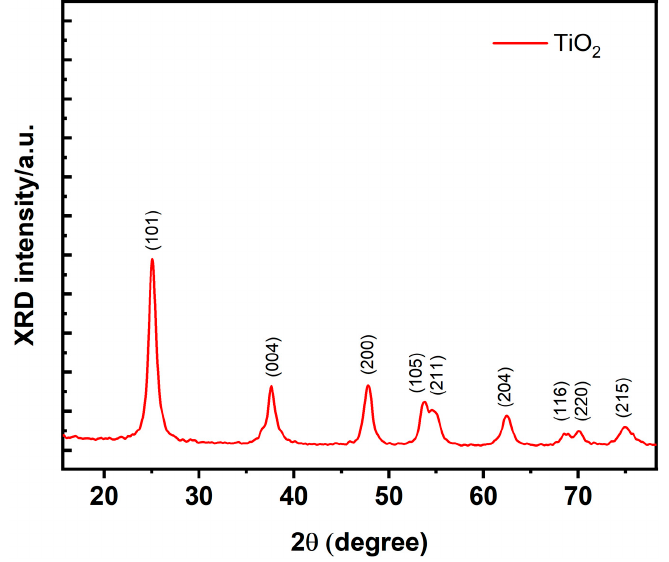
Figure 3. XRD patterns of TiO 2 nanopowders. ((101), (004), (200), (105), (211), (204), (116), (220), and (215)) represent the crystal planes of the anatase phase of TiO 2 . Raman spectra were measured on pure TiO 2 , TiO 2 /1 mg-KBrO 3 , and TiO 2 /5 mg- KBrO 3 . KBrO 3 was mixed with TiO 2 nanoparticles and then milled. Afterward, a drop of water was added to dissolve KBrO 3 to form a gel. After 1 h of drying, we put a small